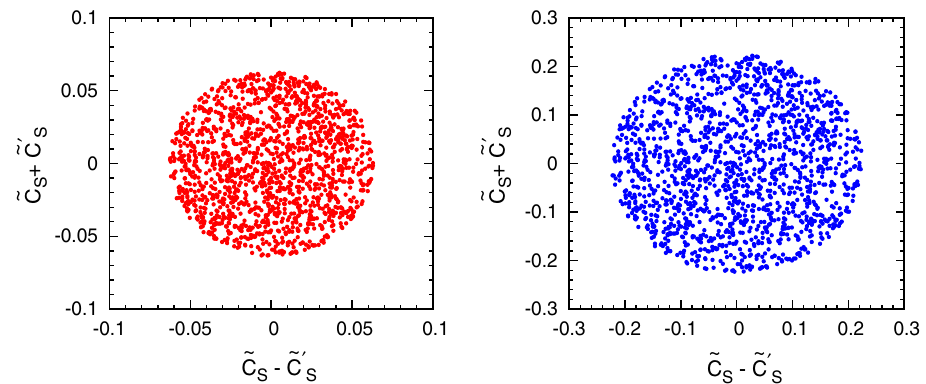
Fig. 1 The allowed region for the ˜ C S ± ˜ C (cid:2) Wilson coefficient obtained from D 0 → μ + μ − ( left panel ) and D 0 → e + e − processes ( right panel ) S